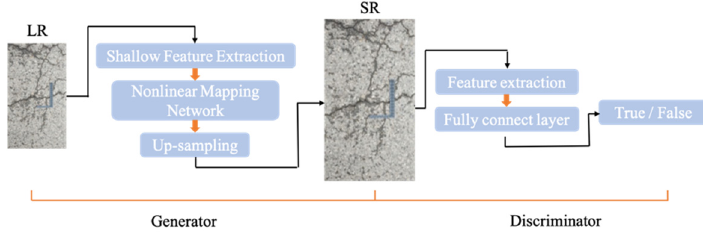
Figure 1. The structure of the attention generative adversarial network.